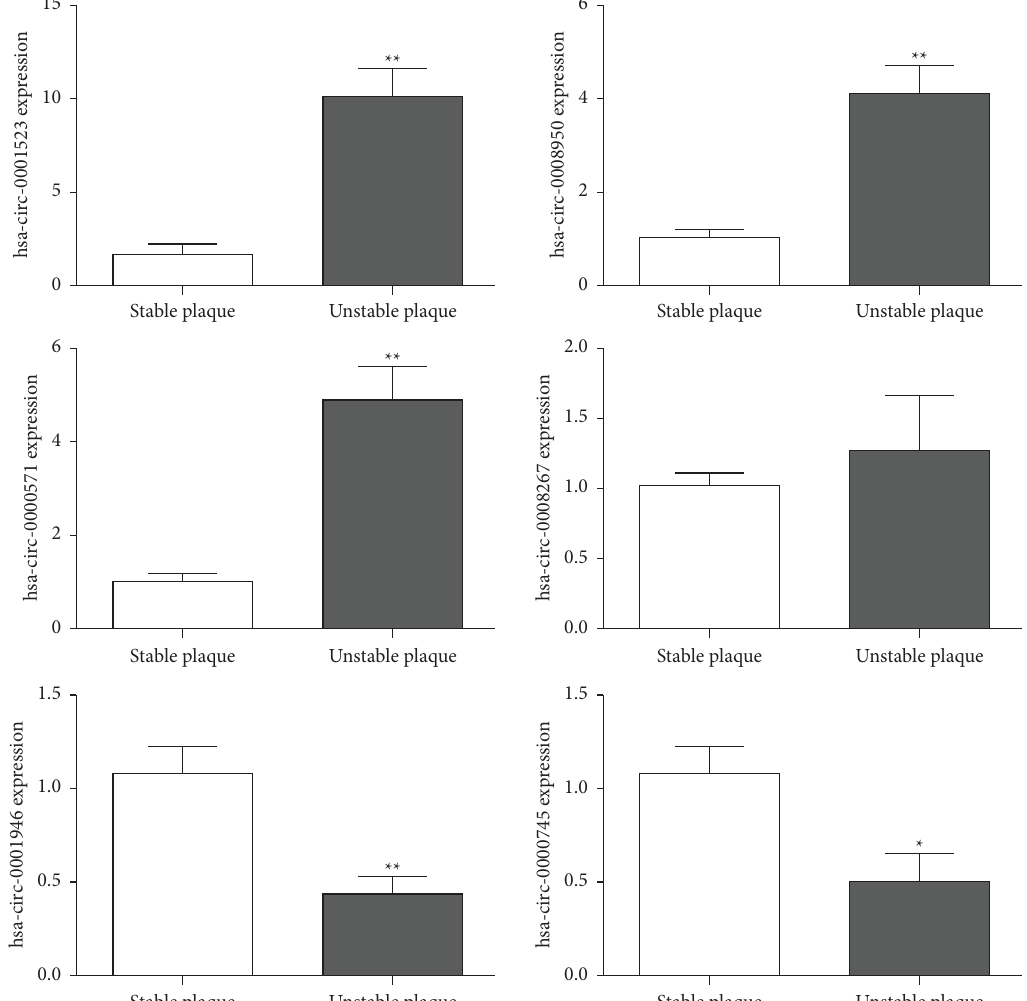
Figure 4: qRT-PCR validation of six DE circRNAs. Four upregulated circRNAs and two downregulated circRNAs from three stable and three unstable plaques are shown. ∗ P < 0 . 05, ∗∗ P < 0 . 01 compared with the stable